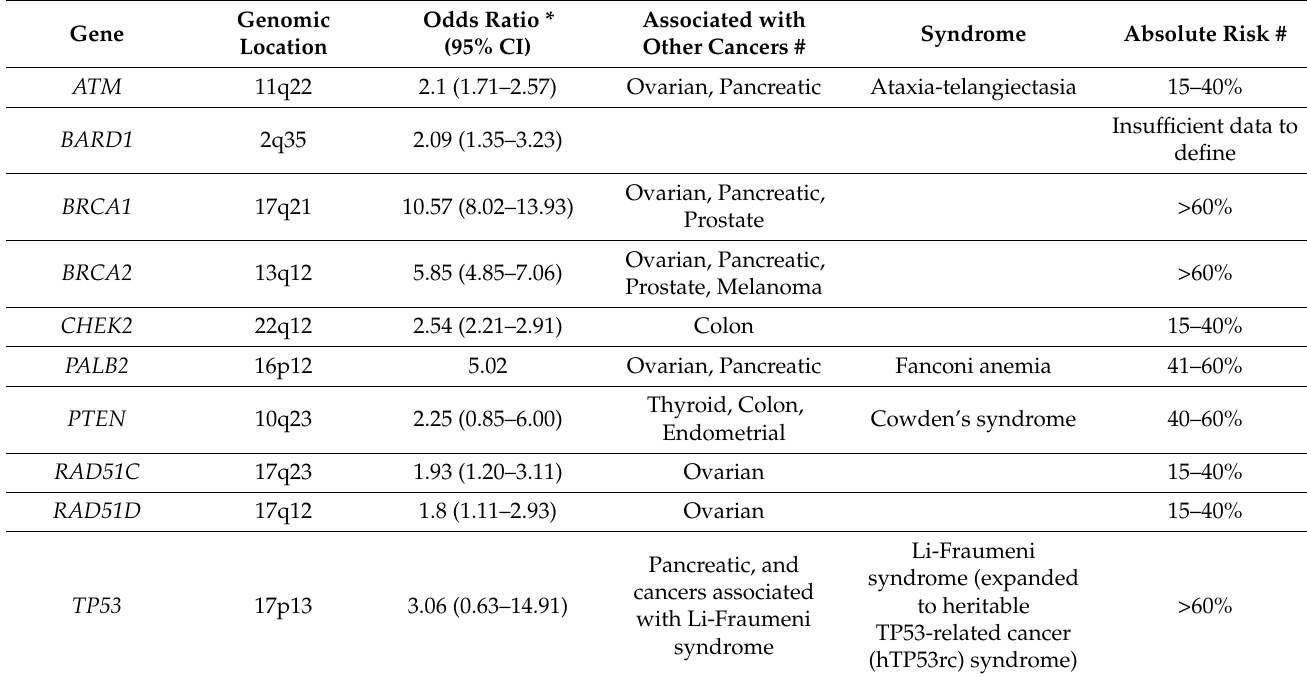
Table 1. Summary of high- and moderate-penetrance breast cancer susceptibility